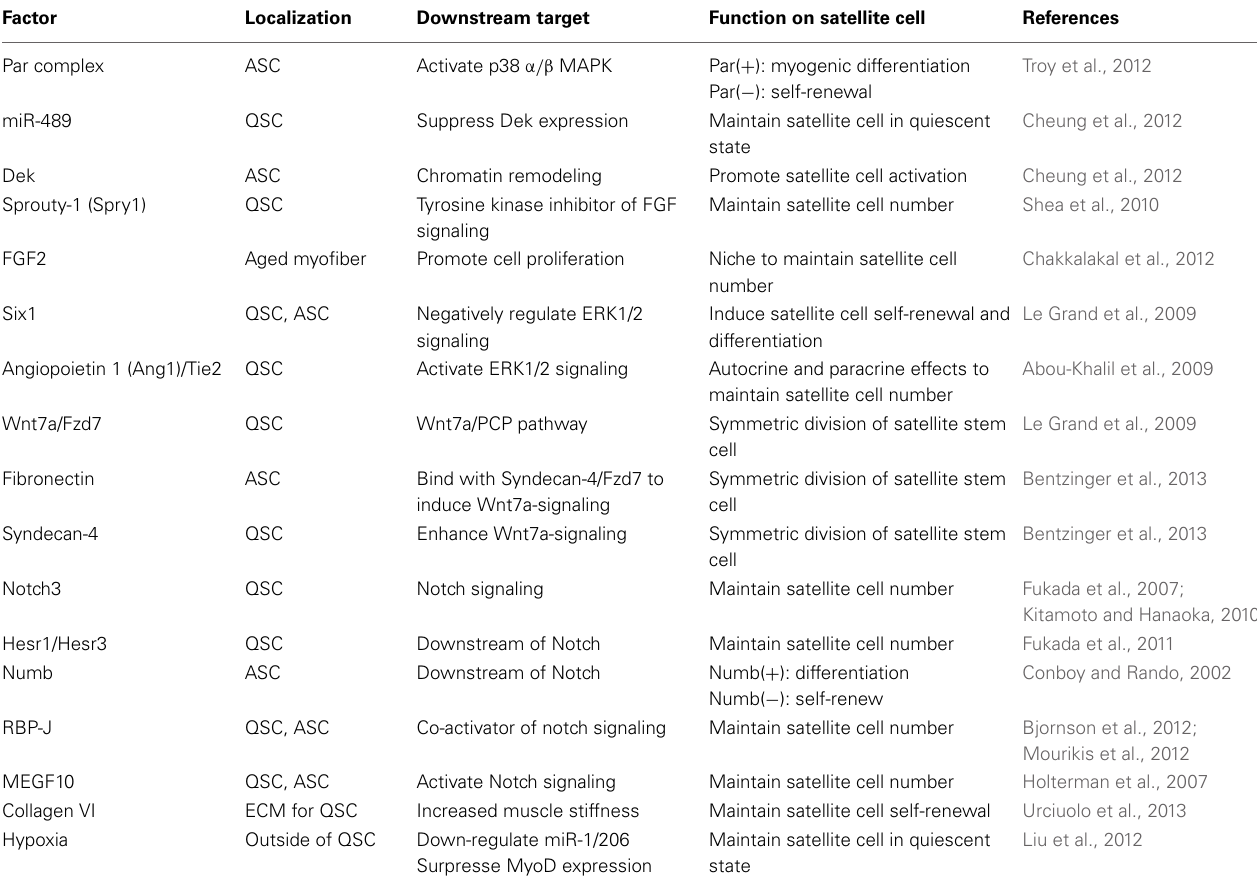
Table 1 | Regulatory molecules and niches for satellite cell